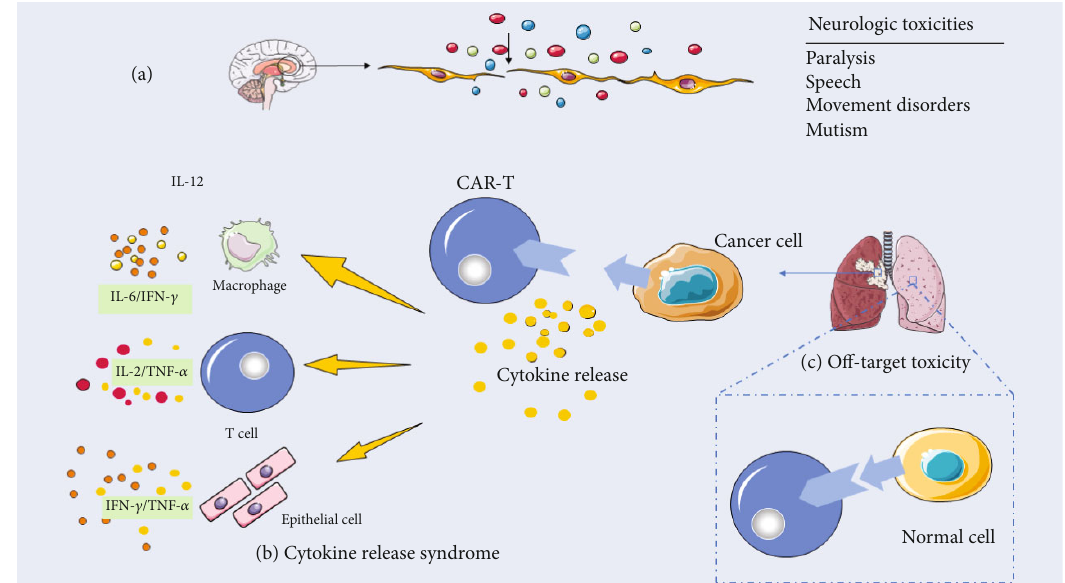
Figure 2: Common side e ff ects of CAR-T cell therapy. (a) CAR-T cells can be examined in routine examinations of cerebrospinal fl uid, which allows increased transport of CAR-T cells and other lymphocytes to the central nervous system and increases permeability to soluble mediators. (b) Cytokine storms are the most common form of CAR-T toxicity. The a ffi nity and conduction function of CAR-T cells cause rapid release of a large number of cytokines such as TNF- α , IL-1, IL-2, IL-6, IFN- α , and IFN- γ to cause acute respiratory distress syndrome after binding to relevant antigens and multiple organ failure. (c) O ff -target e ff ects are the e ff ect of cells on additional targets outside of the design, leading to autoimmune disease responses to normal